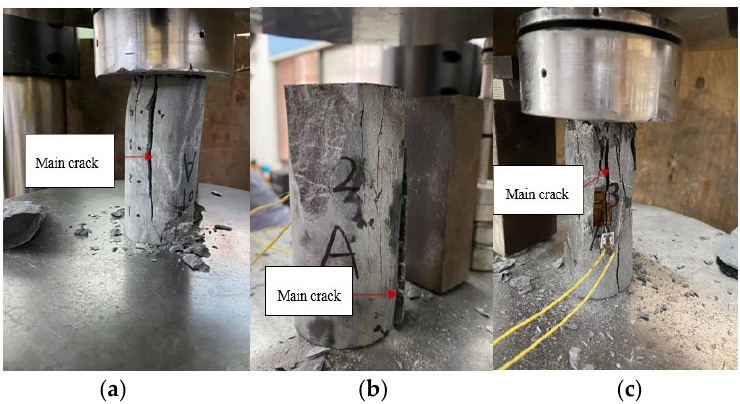
Figure 7. Failure mode of rock sample under uniaxial compression. ( a ) A01; ( b ) A02; ( c ) A03.